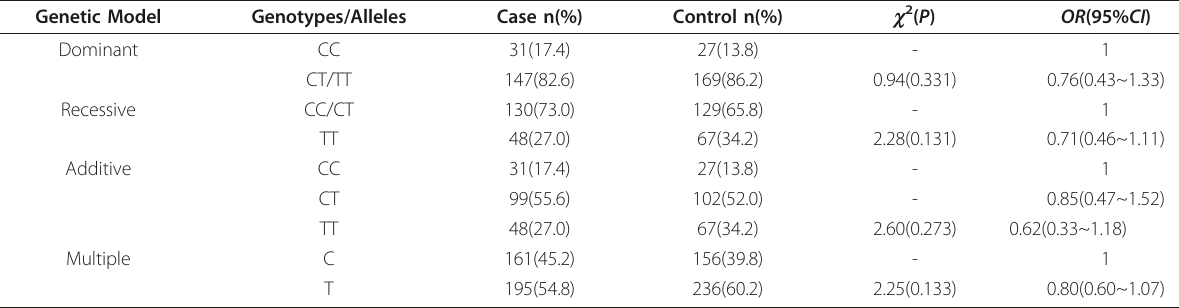
Table 5 Frequency of rs1042489 genotypes/alleles under different genetic